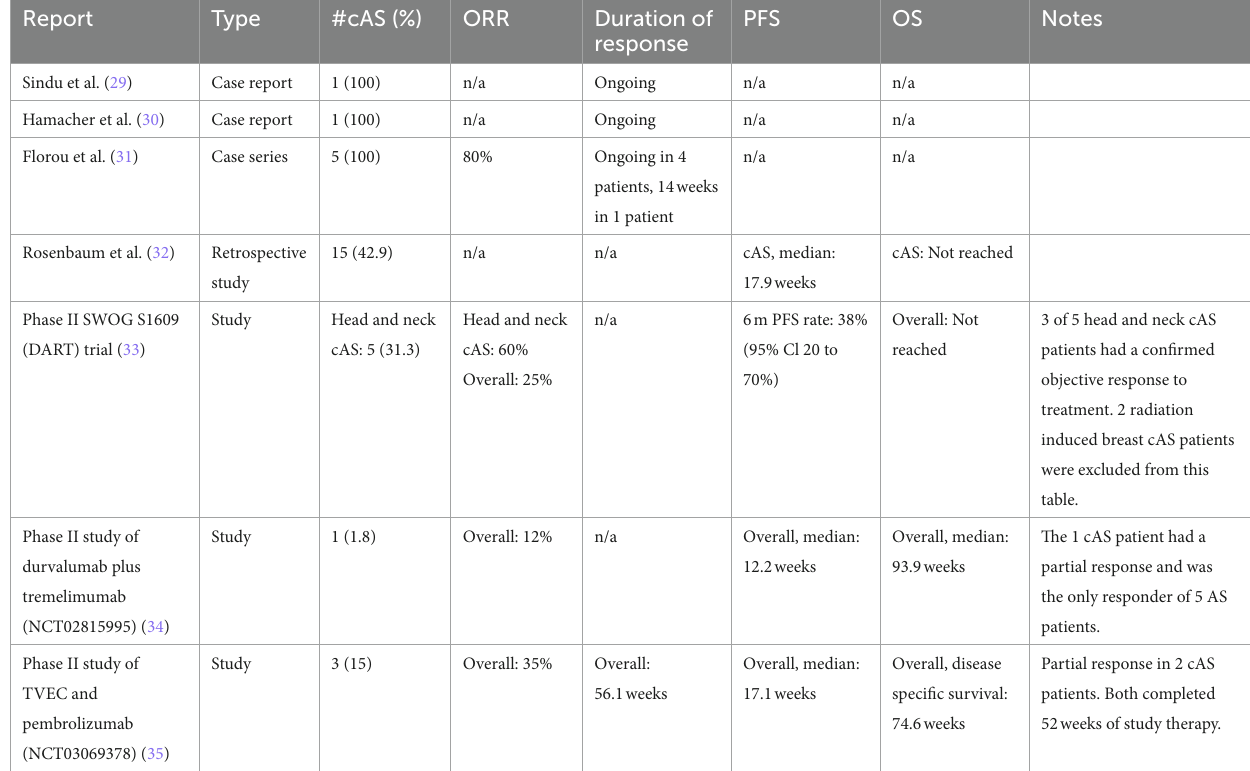
TABLE 1 Summary of case reports, case series, and completed clinical